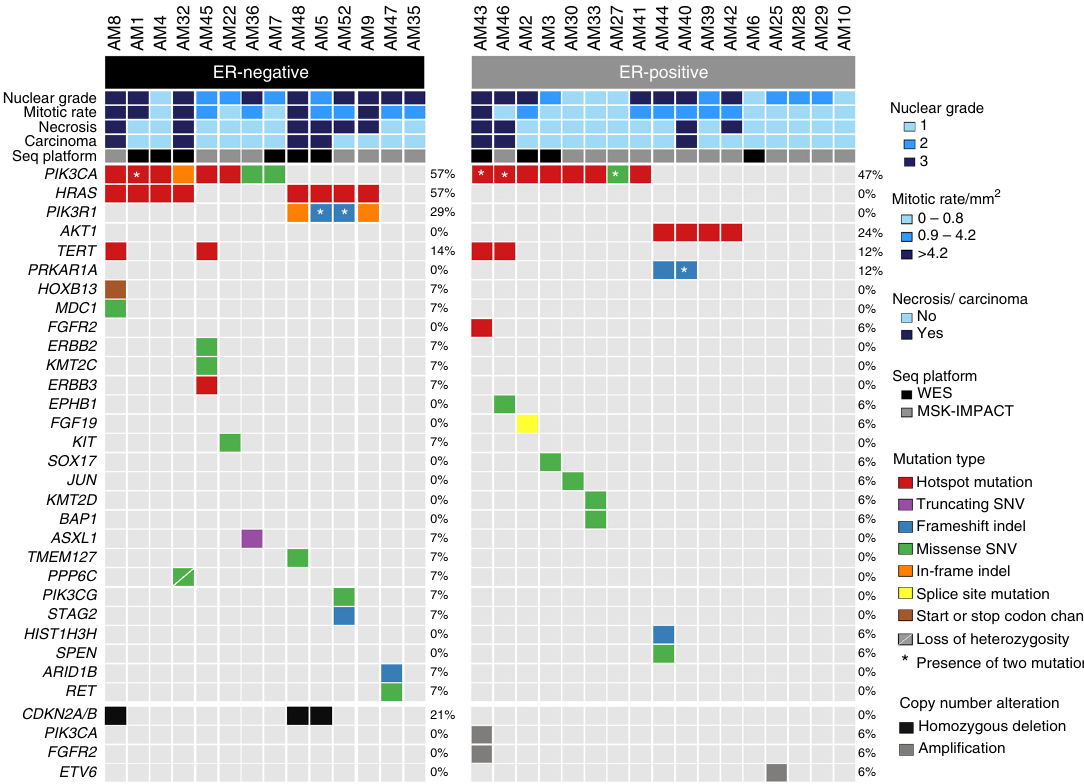
Fig. 2 Repertoire of somatic genetic alterations in breast adenomyoepitheliomas. Heatmap depicting the somatic genetic alterations identi fi ed in 31 breast adenomyoepitheliomas subjected to whole-exome (WES, n = 10) or MSK-IMPACT ( n = 21) sequencing. Somatic mutations affecting the 410 genes present in the MSK-IMPACT assay are plotted, in decreasing overall mutational frequency, followed by selected genes affected by ampli fi cations or homozygous deletions at the bottom. Cases are shown in columns (estrogen receptor (ER)-negative cases on the left; ER-positive cases on the right), and genes in rows. Histopathologic characteristics and sequencing platforms are shown in the phenotype bars at the top. Genetic alterations are color-coded according to the legend. Loss of heterozygosity (LOH) is represented by a diagonal bar. The presence of two mutations in the same gene is indicated by an asterisk. In cases subjected to WES, hotspot mutations affecting the promoter of TERT were investigated by Sanger sequencing. Hotspot mutations were obtained from Chang et al. 57 . Seq platform, sequencing platform employed; SNV, single nucleotide variant; indel, small insertion or